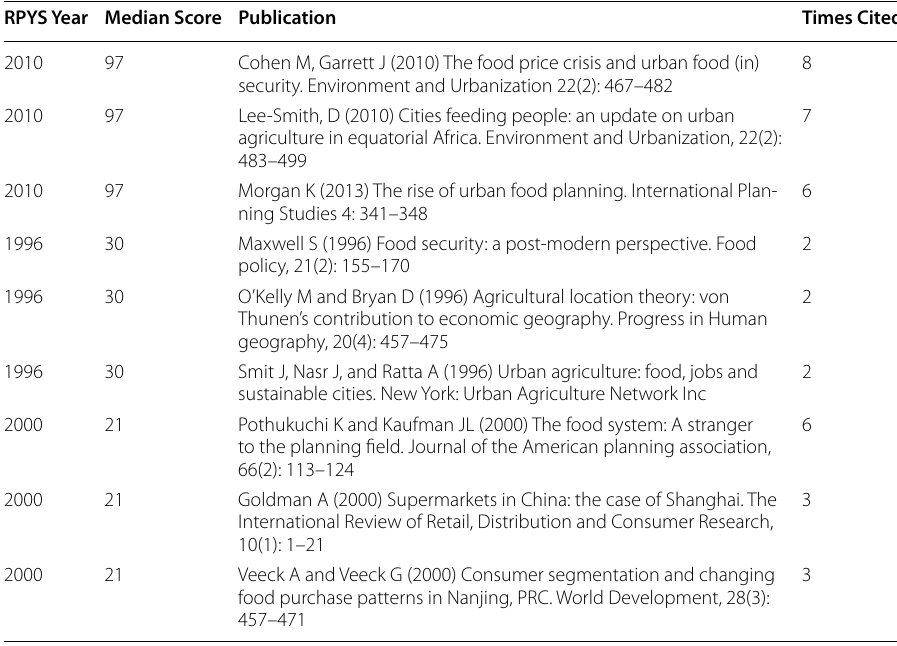
Table 4 Standard Reference Publication Year Spectroscopy (RPYS) RPYS Year Median Score